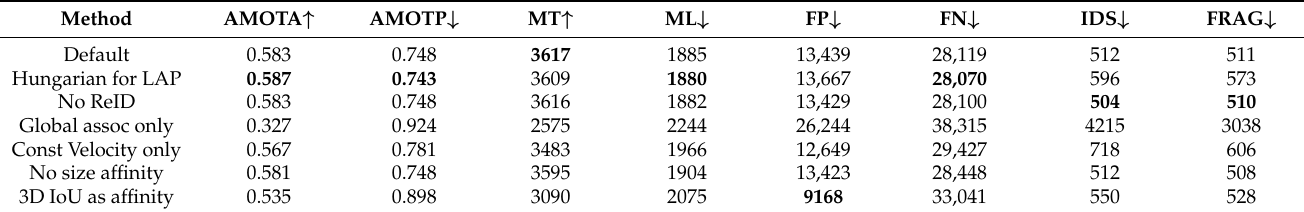
Table 4. Ablation study using NuScenes